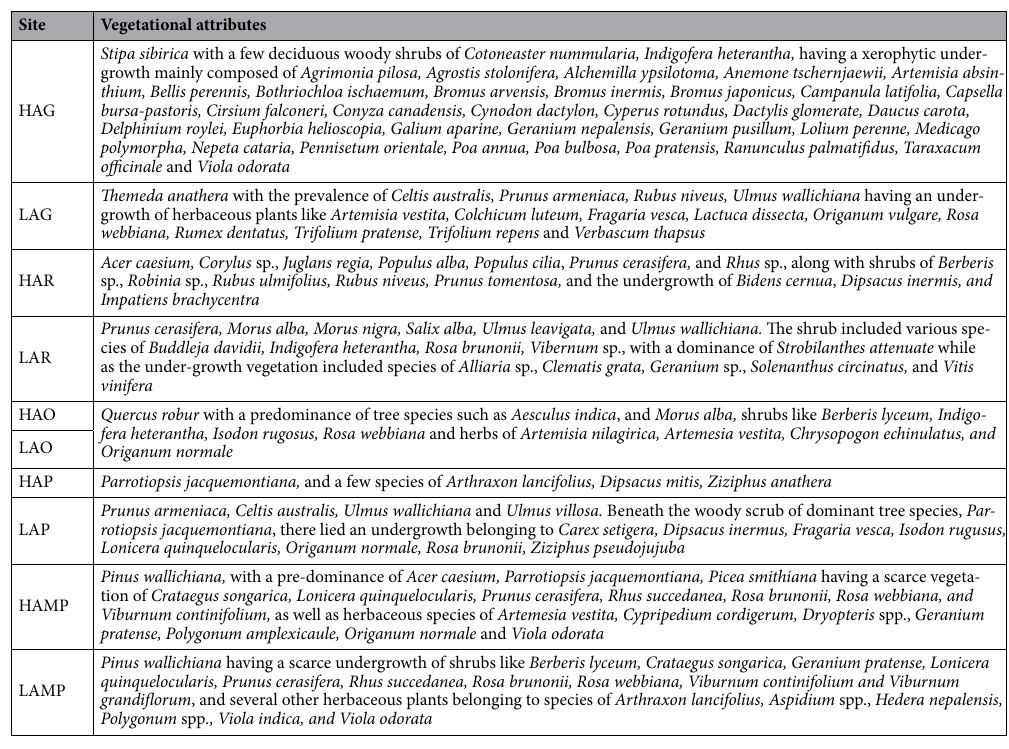
Table 3. Vegetational characteristics of different study sites in lower Dachigam National Park,